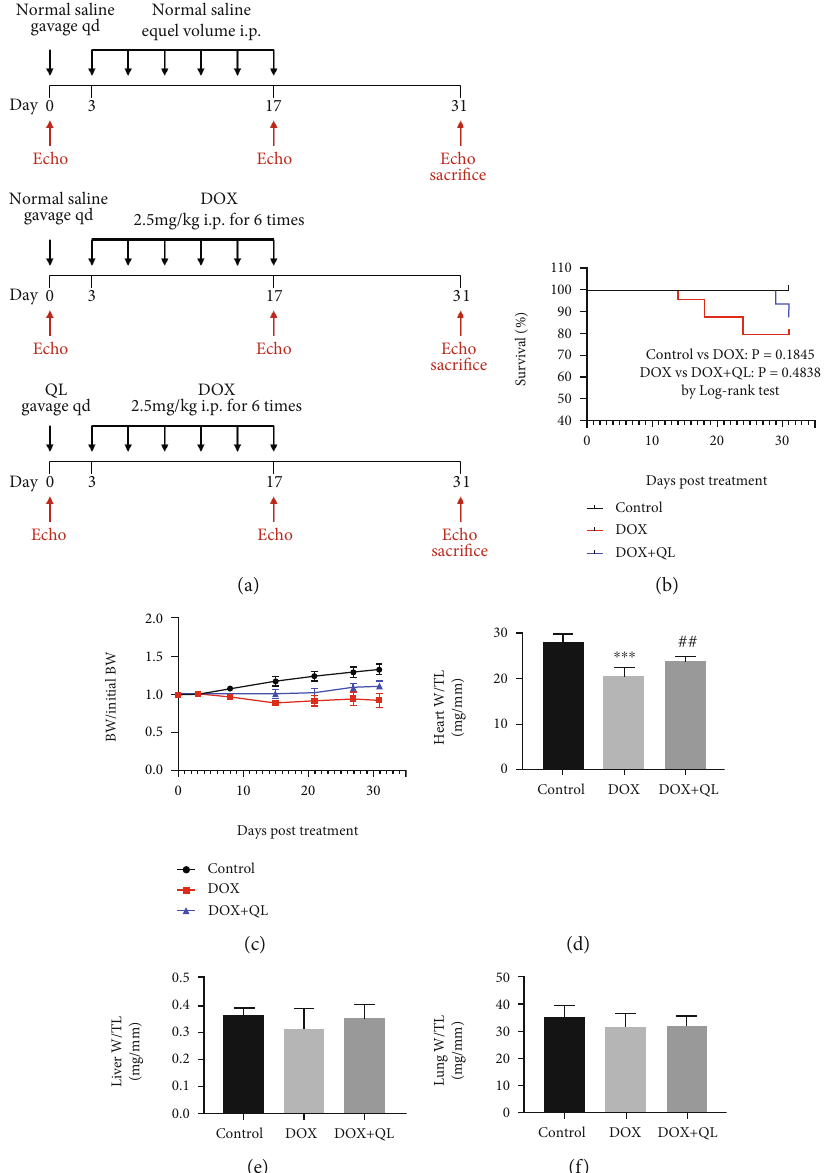
Figure 2: The impacts of QL treatment on survival rate, weight loss, cardiac mass, liver mass, and lung mass in DOX-treated rats. (a) The schematic diagram of this study. (b) Survival curve and (c) body weight change of rats in three groups during the experiment. (d – f) The ratios of heart weight, lung weight, and liver weight to tibial length (TL) among three groups at the end of the experiment (values are presented as mean ± SD ; ∗∗∗ P < 0 : 001 vs. control group; ## P < 0 : 001 vs. DOX